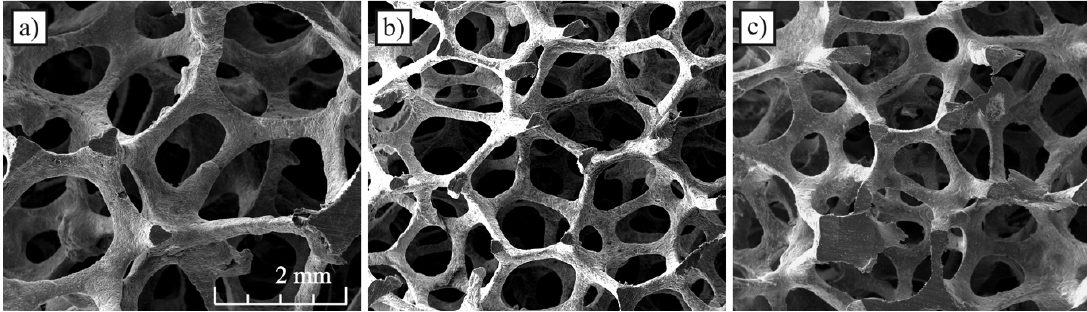
Figure 1. Open − cell aluminum foams applied in the experiments: ( a ) 20 PPI, ( b ) 30 PPI, ( c ) 40 PPI.